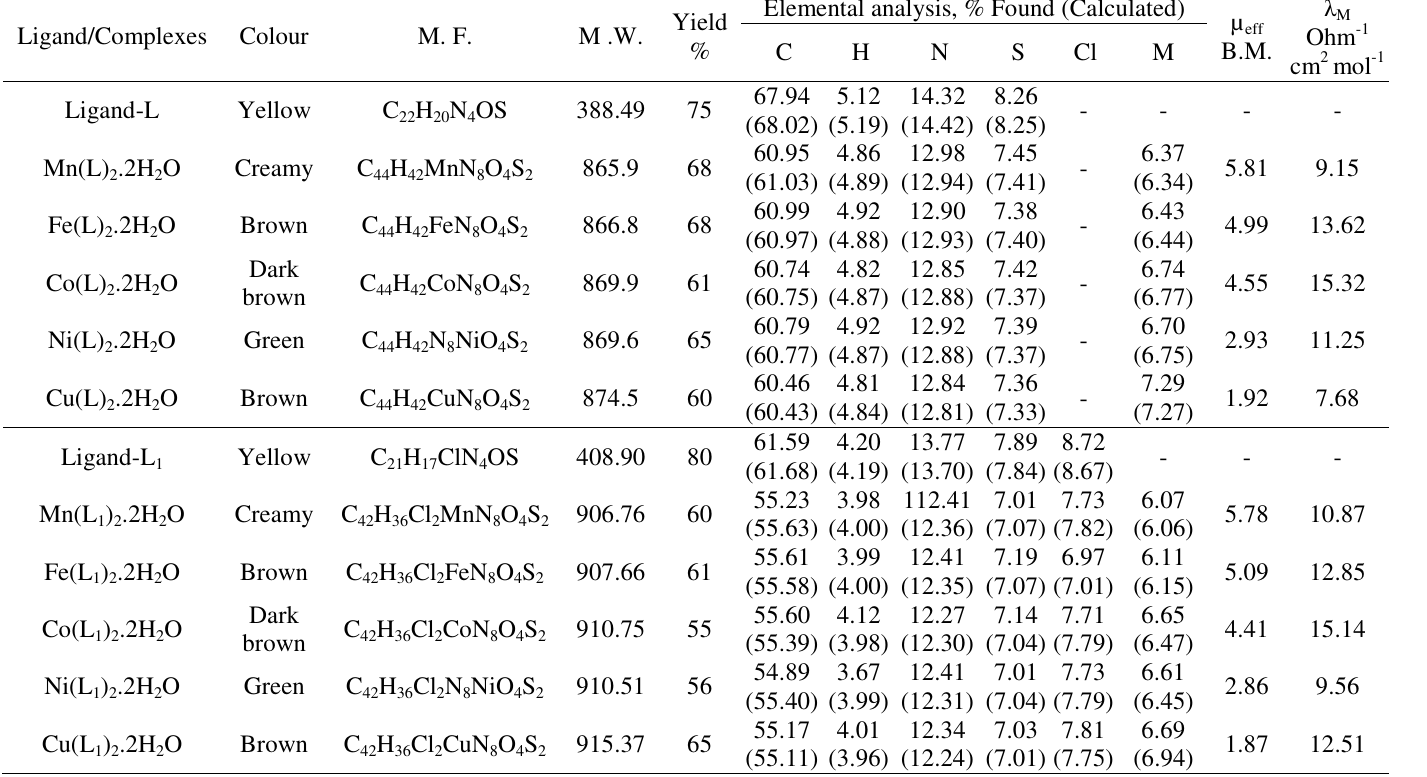
Table 1. Analytical and physical data of Schiff base ligands and their metal complexes Elemental analysis, % Found